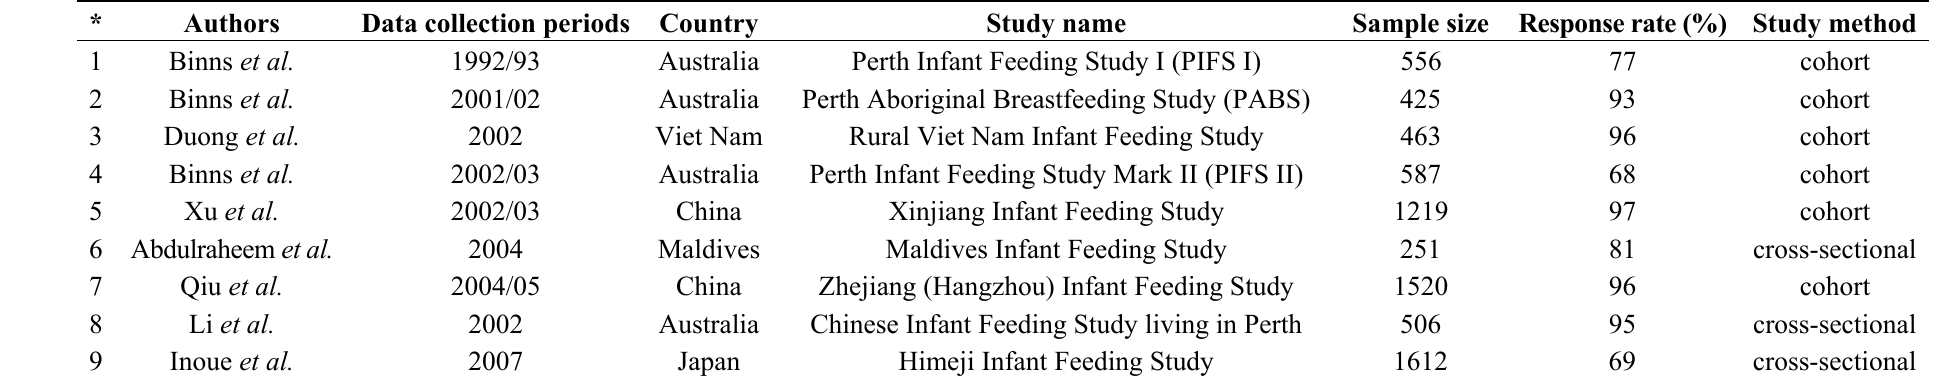
Table 1. Details of the infant feeding studies in Asia Pacific region.